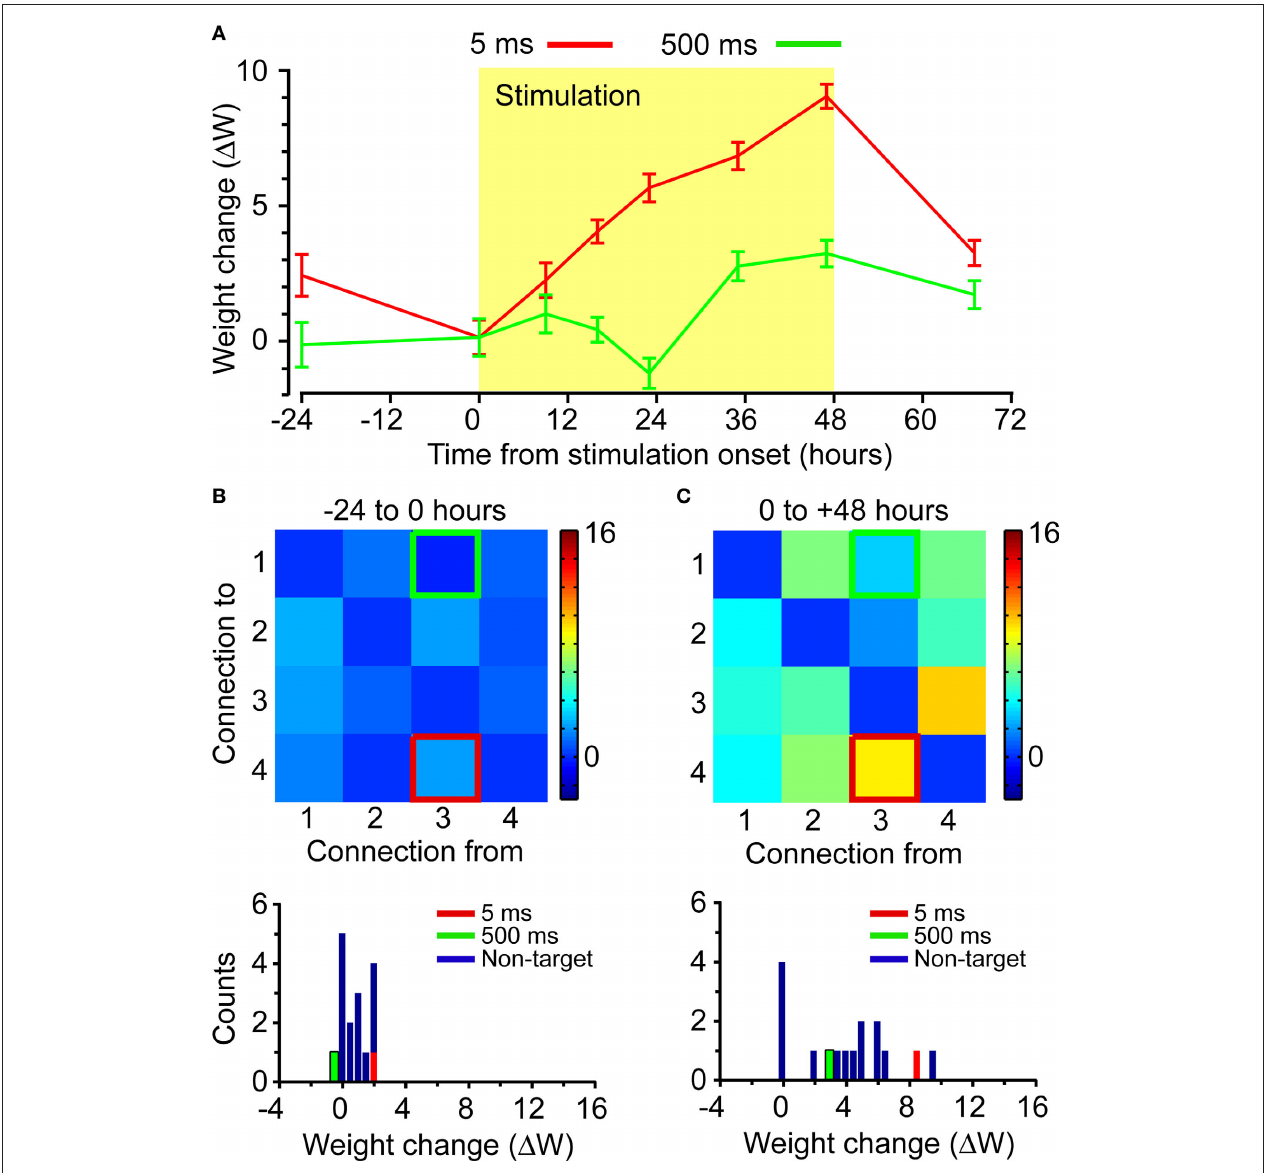
Figure 6 | Connectivity changes from combined stimulation. Two target electrodes were stimulated in a single experiment, each at a different latency with respect to the trigger spikes. Red indicates the connection stimulated at 5-ms latency; green indicates the connection stimulated at